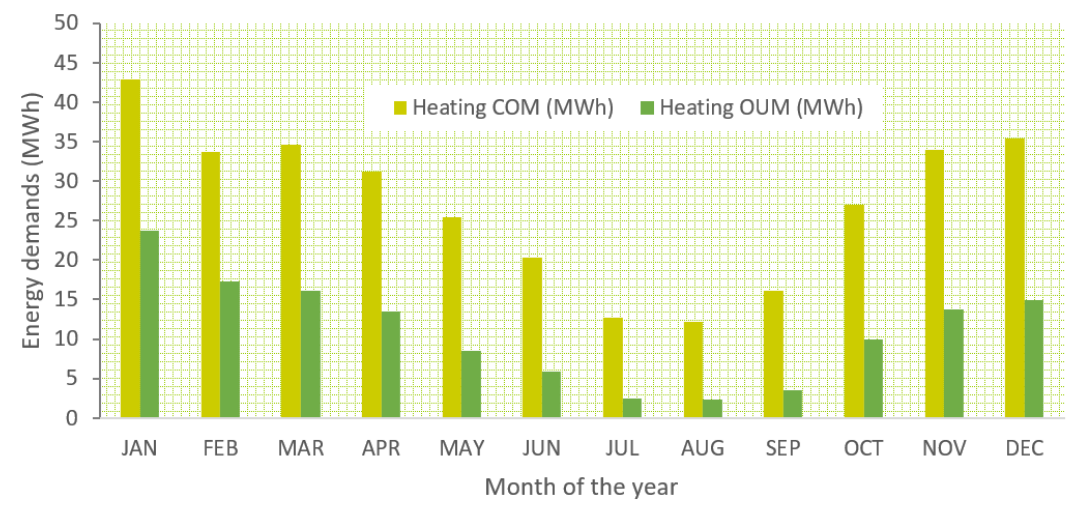
Figure 16. Monthly heating energy demand of the surgical suite during current operation mode (COM) and o ff -use operation mode